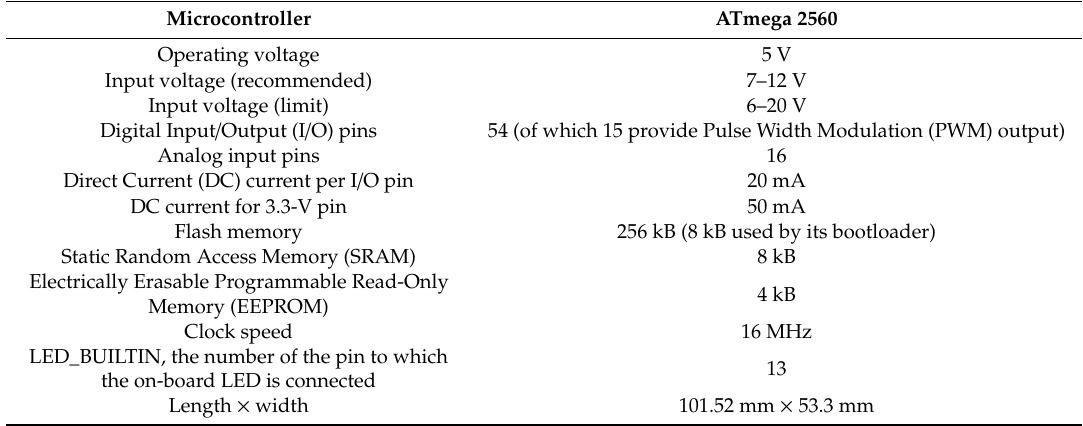
Table 1. Technical specification of Arduino MEGA 2560 [34,35].